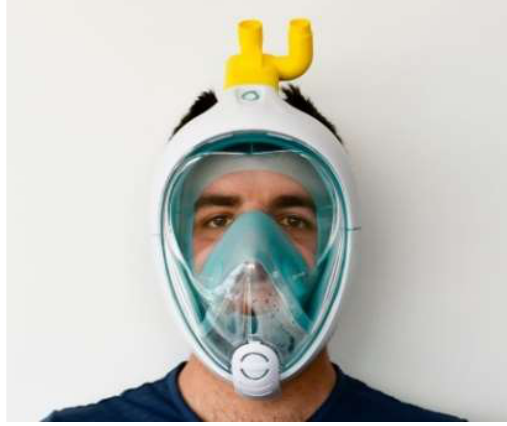
Figure 7. Easybreath scuba mask modified to PARP using Charlotte valve [59].